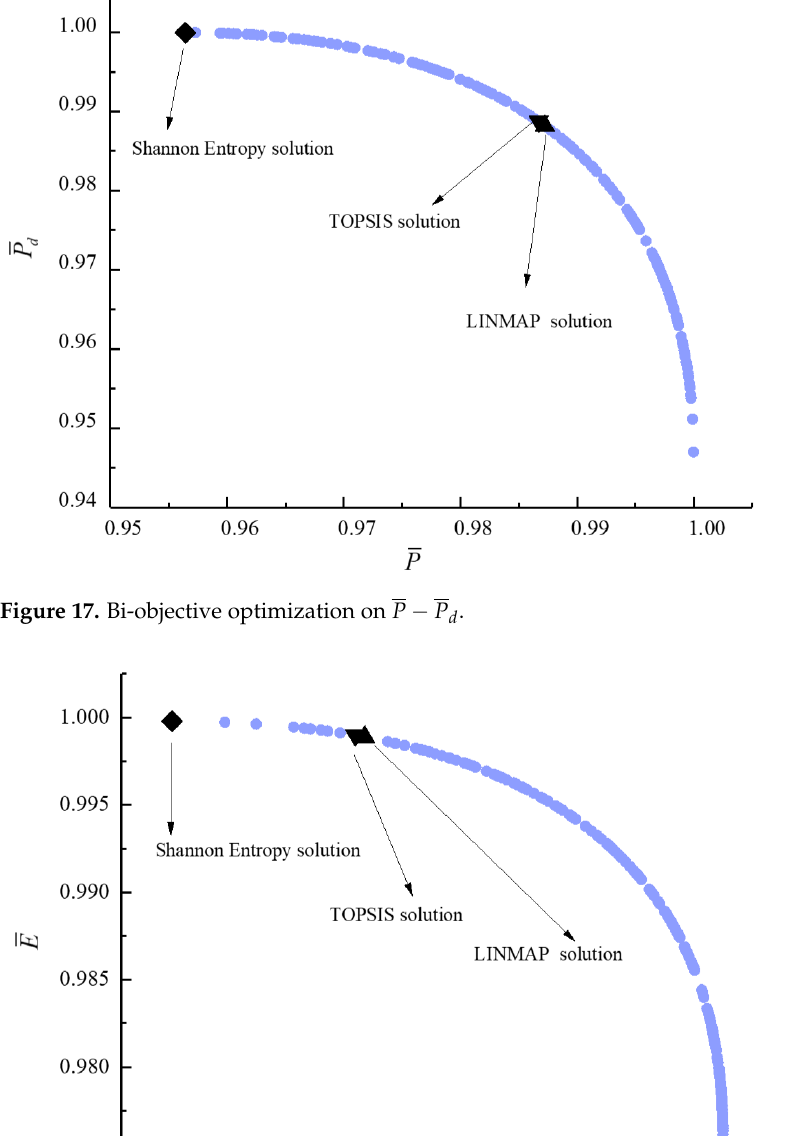
Figure 16. Bi-objective optimization on P E − .